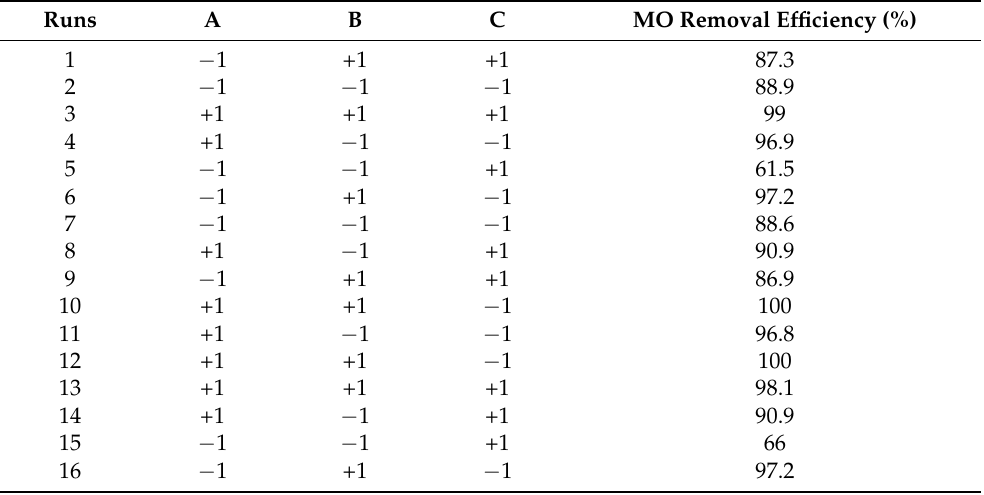
Table 2. The factorial design matrix and the experimental response results for MO removal efficiency. Runs